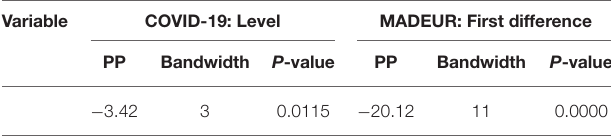
TABLE 2 | Stationarity test for MADEUR and COVID-19 new cases using Phillips-Perron test. Variable